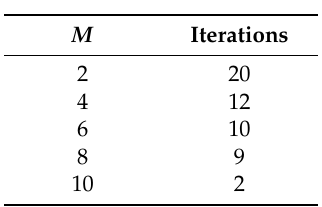
Table 5. The number of ants and iterations.